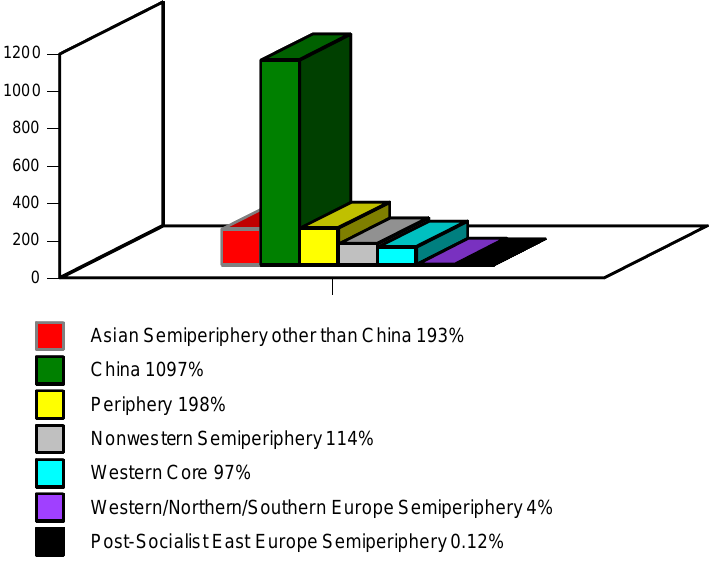
Figure 1. Semiperipheral Challenges to the Core, 1980-2015 Part A: Percentage Growth in GDP Per Capita,